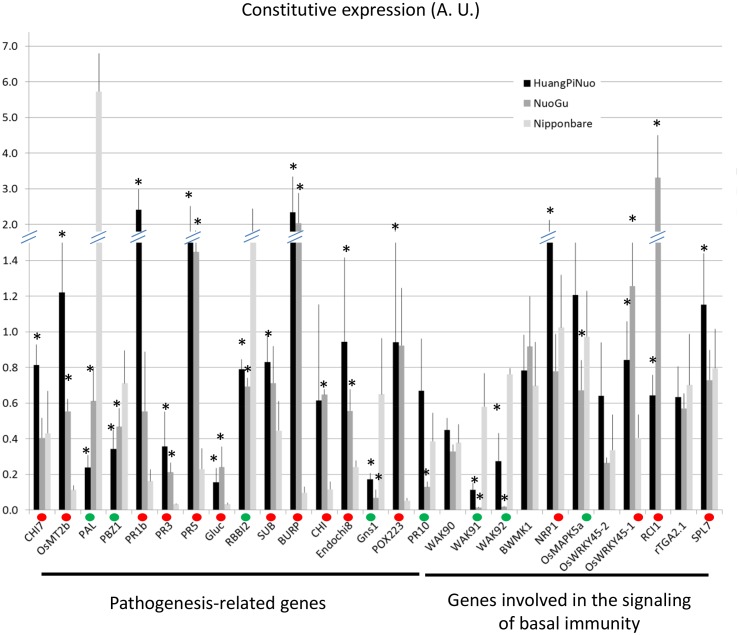
Constitutive expression of defense-related genes in Yuanyang japonica and Nipponbare varieties.The japonica variety Nipponbare with high basal immunity was compared to the Yuanyang japonica varieties Huang Pi Nuo and Nuo Gu. The constitutive expression of 16 pathogenesis-related genes and 11 genes involved in basal immunity signaling was measured by RT-qPCR. In order to compare all genes together, all values for one gene were normalized with the average value of the considered gene for all measures. The values are the means and SD from four biological replicates. The ‘*’ denote statistical differences (t-test; p<0.05) between Nipponbare and the considered variety. A red and green dot indicates that Nipponbare expression is lower and higher than either Huang Pi Nuo or Nuo Gu respectively.